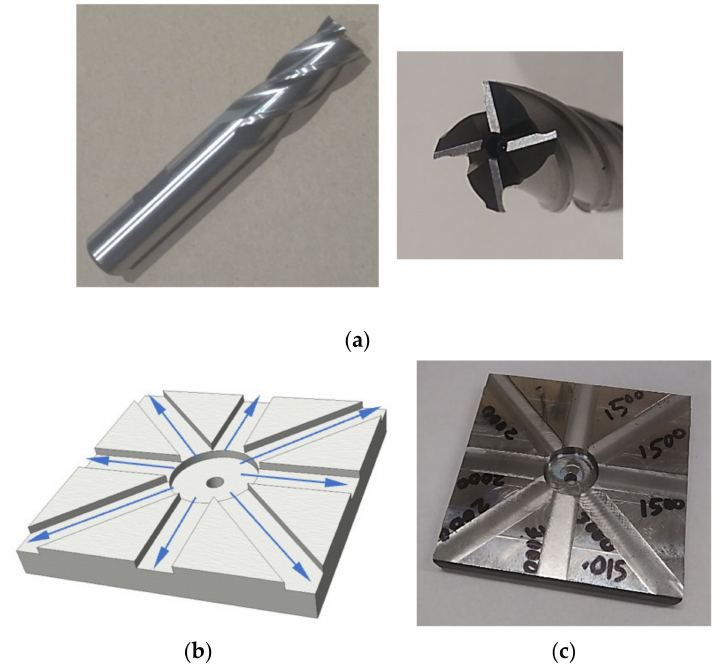
Figure 2. ( a ) End milling cutter, ( b ) milling paths, and ( c ) machined workpiece